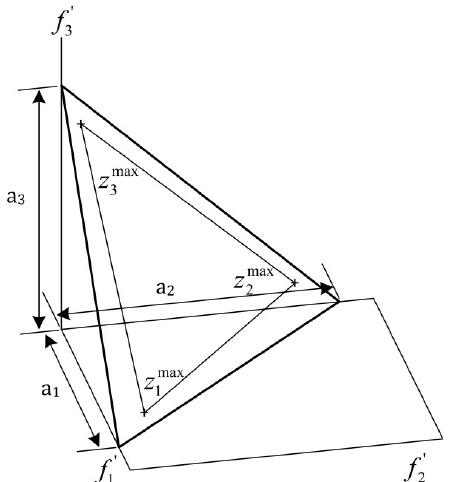
Figure 9. Hyperplane: The three-objective optimization problem taken as an example.